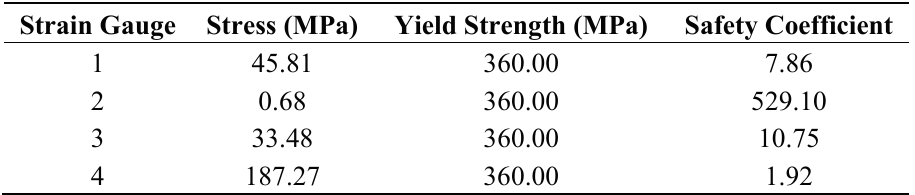
Table 4. The von Mises stresses and safety coefficients obtained from measurements registered by the strain gauges in the field with loam texture (field 1), at a forward speed of 7 km/h and an application depth of 0.17 m.